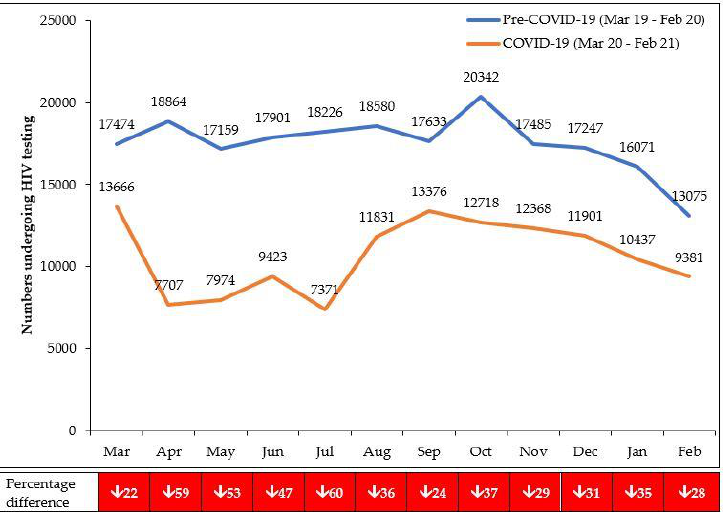
Figure 5. Numbers presenting each month for HIV testing in eight facilities in Lilongwe, Malawi, during pre-COVID-19 and COVID-19 periods. HIV services resumed after lockdown; HIV testing was also offered to contacts of HIV-positive index clients